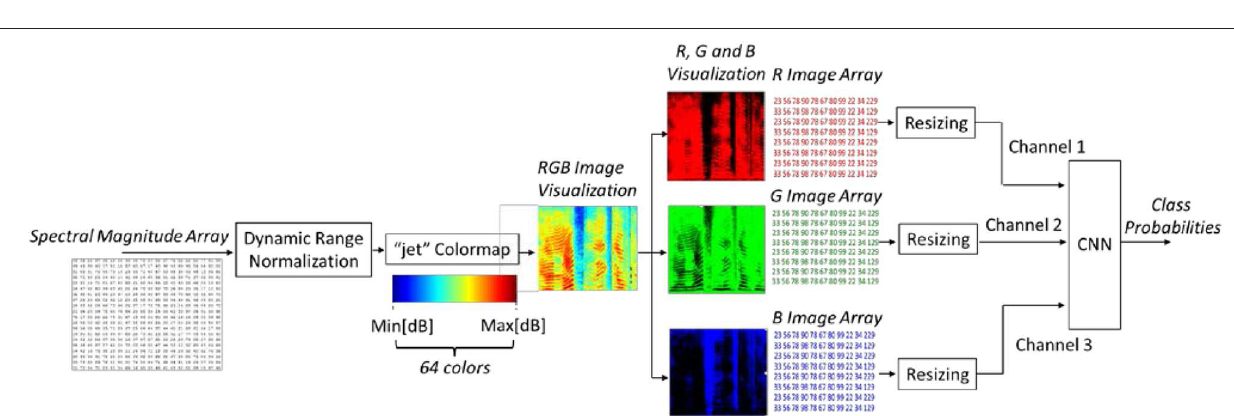
FIGURE 6 | Examples showing the effect of different normalization of the dynamic range of spectral magnitudes on the visualization of spectrogram details; (a) Min = − 156 dB, Max = − 27 dB—good visibility of spectral components of speech, (b) Min = − 126 dB, Max = − 100 dB—an arbitrary range showing poor visibility, (c) Min = − 50 dB, Max = − 27 dB—another arbitrary range showing poor visibility. For all sub-pictures, the frequency range is 0–8kHz, and the time range is 0–1s.